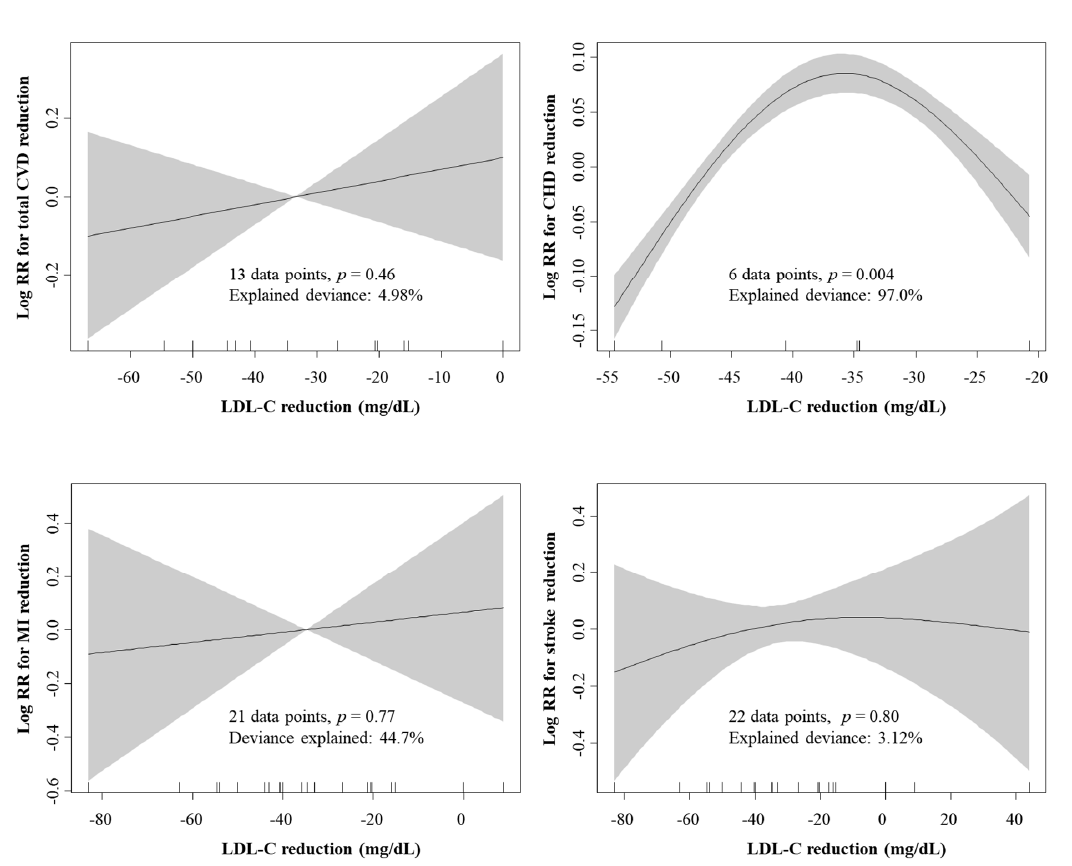
Figure A2. Non-linear association between cardiovascular event reduction and LDL-C lowering effects of statins. Cardiovascular events include total cardiovascular disease (CVD), coronary heart disease (CHD), myocardial infarction (MI), and stroke. RR, relative risk; CVD, cardiovascular disease; CHD, coronary heart disease; MI, myocardial infarction; LDL-C, low-density lipoprotein cholesterol.